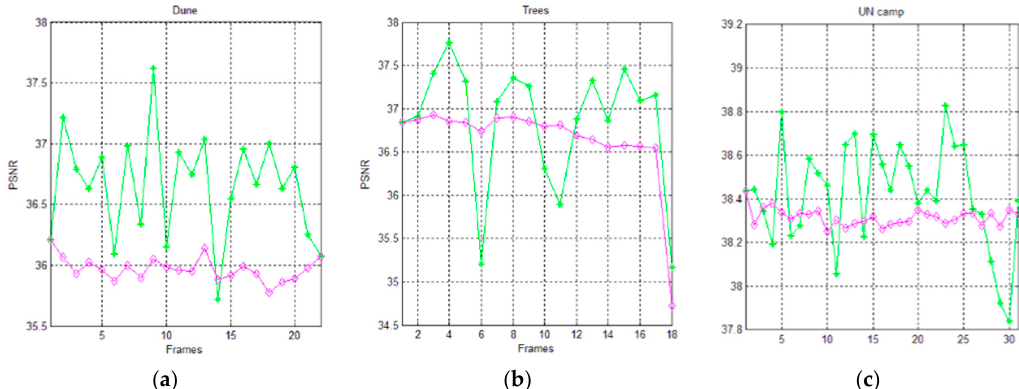
Figure 14. Graphical comparison of the achieved PSNR between the AVQ algorithm (green line) and the AVQ IS algorithm (magenta), by using a dictionary of 8192 (2 13 ) entries, for ( a ) the Dune sequence; ( b ) the Trees sequence; and ( c ) the UN camp sequence.